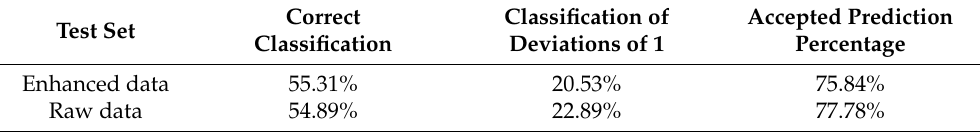
Table 2. The condition prediction results of the mixing ratio